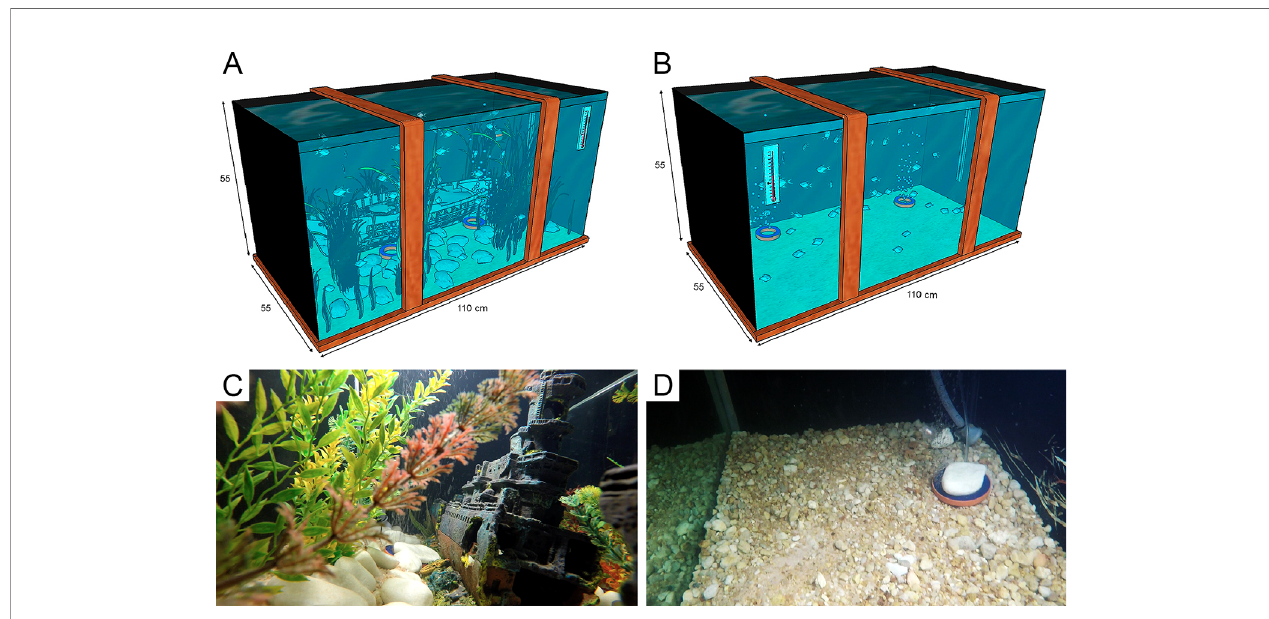
FIGURE 1 | Small-scale enriched (A , C) and impoverished (B , D) aquaria. EE aquarium contains a running water fl ow pump for voluntary exercise and natural plants and a resin boat to provide rest and shelter. The IE aquarium did not contain any of these